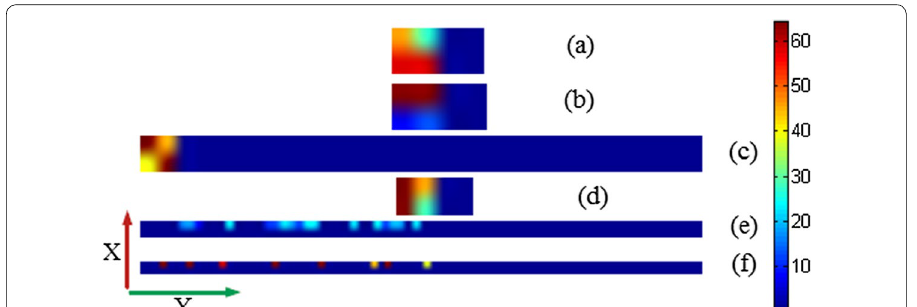
Fig. 4 U matrix values, k 2 (a) hospital and BPI‑2012 dataset, (b) scientific and hospital dataset, (c) BPI‑2017 = and scientific dataset, (d) scientific and BPI‑2012 dataset, (e) hospital and BPI‑2017 dataset, (f) BPI 2012 and BPI 2017 dataset. The X axis shows feature vectors and the Y axis represents workflow